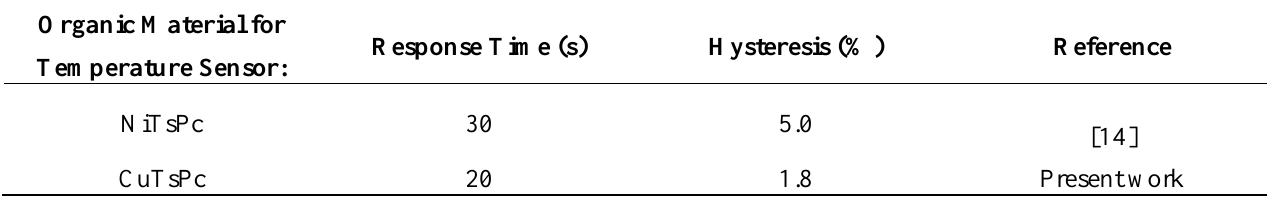
Table 1. The comparison between NiTsPc and CuTsPc based temperature sensor. Organic Material